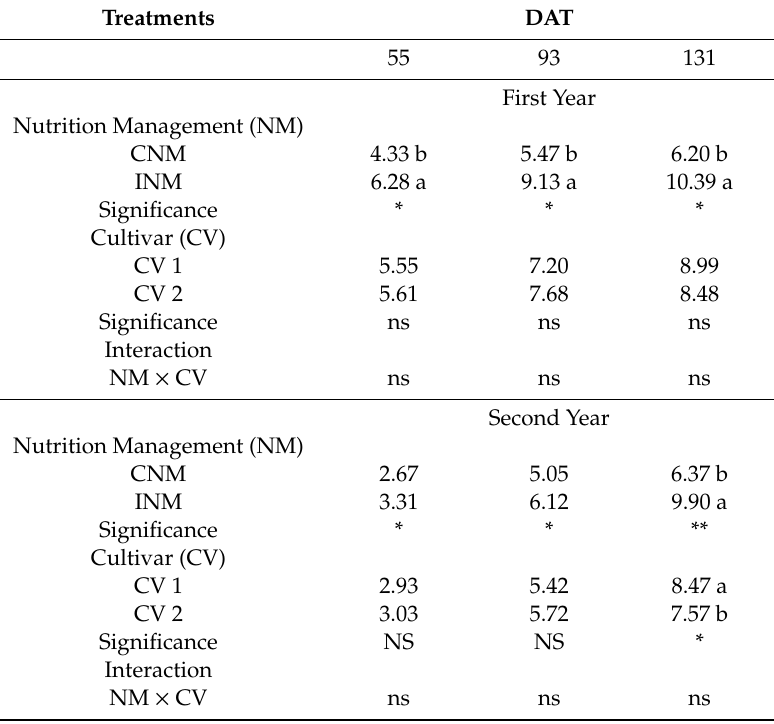
Table 6. Main e ff ects of nutrient management and cultivar on N accumulation (g m − 2 ) at three di ff erent days after transplant (DAT) in chrysanthemum plants over the two years of